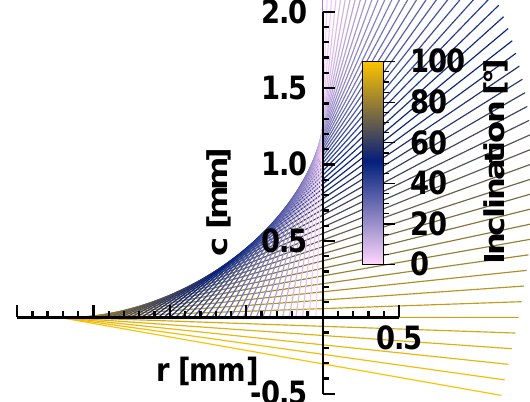
Figure 1: Shifting of projection center along optical axis One subclass consists of camera systems where all object rays intersect approximately in one unique point, i.e. the projection center. This constraint is called single viewpoint (SVP). All other camera systems that do not obey the SVP, i.e. with many pro- jection centers, represent the other subclass. An incident angle dependent projection center is depicted in figure 1. Here, the intersection of object ray and optical axis depends on the inclina- tion and is shifted accordingly on the optical axis. The approach of parametric camera modeling defines a mathematical projection that is based on a small set of parameters, which projects a partic- ular object ray, represented by its incident angle θ , onto an unique image point, represented by its radial distance r to the principal point, and vice versa.